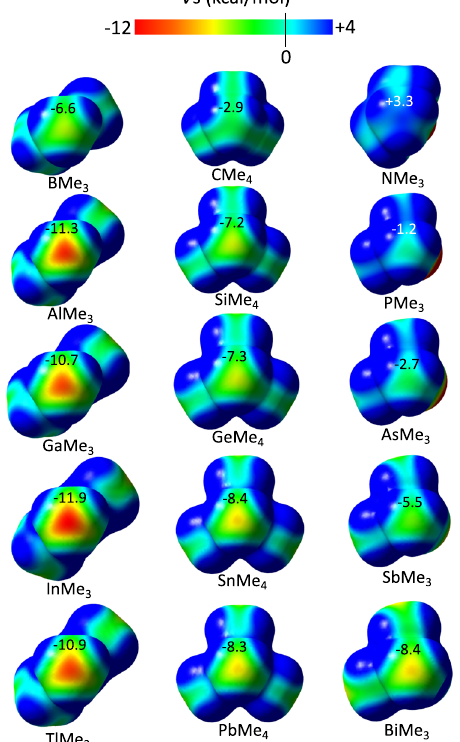
Fig. 1 Electron density distribution for differently substituted methyl groups. Molecular electrostatic potential (MEP) maps for compounds E(CH 3 ) 3 (E = B, Al, Ga, In, Tl), E ’ (CH 3 ) 4 (E ’ = C, Si, Ge, Sn, Pb), and E ” (CH 3 ) 3 (E ” = N, P, As, Sb, Bi) with the minimum value of the EP ( V s,min ) at the center of the tetrahedral CH 3 face given in kcal mol – 1